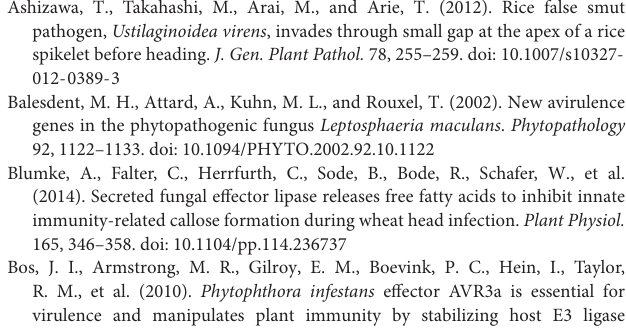
domain suppressing BAX-triggered plant cell death are highlighted in red and bold. The Cys residues in SCRE2 are indicated by asterisks. FIGURE S2 | SCRE2-mCherry-NLS was ectopically expressed in Magnaporthe oryzae . The gene construct SCRE2-mCherry-NLS was transformed into M. oryzae P131 via PEG-mediated transformation. Red fluorescence observed via fluorescence microscopy indicates the expression of SCRE2-mCherry-NLS in M. oryzae conidia. NLS, nuclear localization signal. FIGURE S3 | Sequence alignment of the SCRE2 genes from 33 different U. virens isolates collected from Japan, India, America, and different regions in China. The SCRE2 gene sequences of UV_8b, Japan and Indian isolates were downloaded from PubMed, while other SCRE2 sequences were determined by sequencing PCR products. FIGURE S4 | Expression and subcellular localization of fluorescently tagged SCRE2 in N. benthamiana and in rice protoplasts. (A) SCRE2-GFP was localized to the nuclei, cytoplasm and plasma membrane in rice protoplasts. Green fluorescence was observed in rice protoplasts transiently expressing GFP, SCRE2-GFP and SCRE2(-SP)-GFP via laser scanning confocal microscopy. GFP panels: green fluorescence; mCherry panels: red fluorescence was observed after mCherry-NLS was expressed in rice protoplasts to indicate nuclei; merged panels: overlay images of green and red fluorescence signals demonstrated that SCRE2-GFP and SCRE2(-SP)-GFP were also localized to the nuclei. Scale bar, 5 µ M. NLS, nuclear localization signal. (B) SCRE2-GFP and SCRE2(-SP)-GFP were stably expressed in N. benthamiana. (C) GFP, SCRE2-GFP, and SCRE2(-SP)-GFP were stably expressed in rice protoplasts. (D) mCherry, SCRE2-mCherry and SCRE2(-SP)-mCherry were expressed in N. benthamiana . SCRE2(-SP): SCRE2 without the signal peptide. In (B–D) , upper panels, Western blot analyses probed with anti-GFP ( α -GFP) and anti-mCherry ( α -mCherry) antibody. Protein markers were shown at the left in kDa. Lower panels, Ponceau S staining indicated an equal loading of total proteins. FIGURE S5 | The expression level of different truncated SCRE2 proteins in N. benthamiana detected by western blot analyses. The FLAG-tagged truncated proteins of SCRE2 were detected with an anti-FLAG ( α -FLAG) antibody. Several small truncated proteins were not detectable probably because they are too small to be detected via western blot analyses. Lower panels, Ponceau S staining indicated an equal loading of total proteins. FIGURE S6 | Schematic illustration to generate SCRE2 gene replacement via CRISPR/Cas9 and the strategy of primer design for diagnostic PCR. The gRNA target site for SCRE2 knockout was shown. The SCRE2 gene, upstream and downstream jointing sequences of hph and SCRE2 were amplified using the primer sets P1(F/R), P2(F/R), and P3(F/R), respectively. TABLE S1 | Thirty-three U. virens isolates from United States, India, Japan, and different Provinces in China used for SCRE2 gene sequence analysis. TABLE S2 | The primers used in this